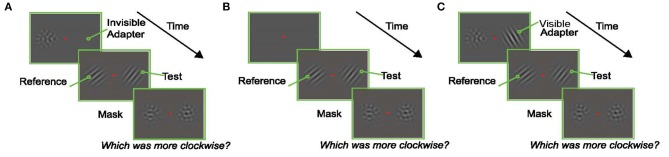
Experimental Paradigms. In each experiment, subjects fixated a central red dot for the duration of the trial. At the end of the trial they reported which of the oriented Gabors in the test display (left or right) was tilted more clockwise. (A) An example trial in the Invisible Adapter TAE experiment. An oriented pattern and a non-oriented mask appeared on either side of the fixation stimulus. The adapter's orientation was chosen at random in each trial to avoid the build-up of plasticity effects across trials, and the spatial frequency of the adapter was chosen such that the subject could not reliably perceive the orientation of the adapter (i.e., it was “invisible”). Immediately after the adaptation phase, an oriented test stimulus appeared on the same side as the adapter while a reference stimulus appeared on the opposite side. Finally, non-oriented masks were presented in both locations. (B) An example trial from the screening experiment. A reference and test stimulus with matching spatial frequencies, but an orientation difference of 20°, were shown for 200 ms. (C) Control experiment which followed the design shown in (A) with the exception that the adapter now had the same low spatial frequency as the test stimulus and was therefore visible to the subject.